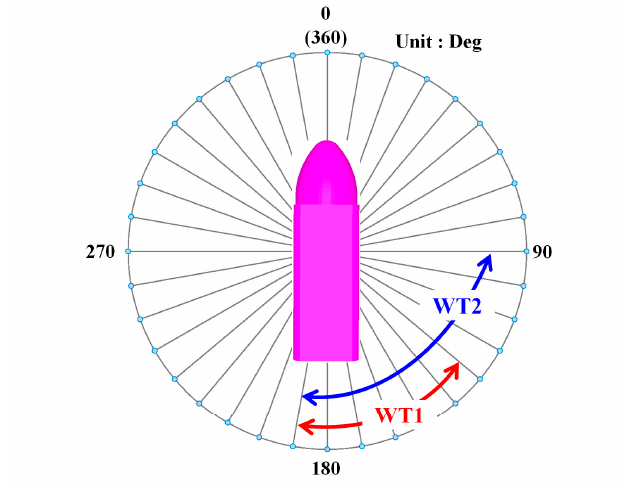
Figure 16. Conceptual diagram of “automatic shutdown program” for WT1 and WT2.